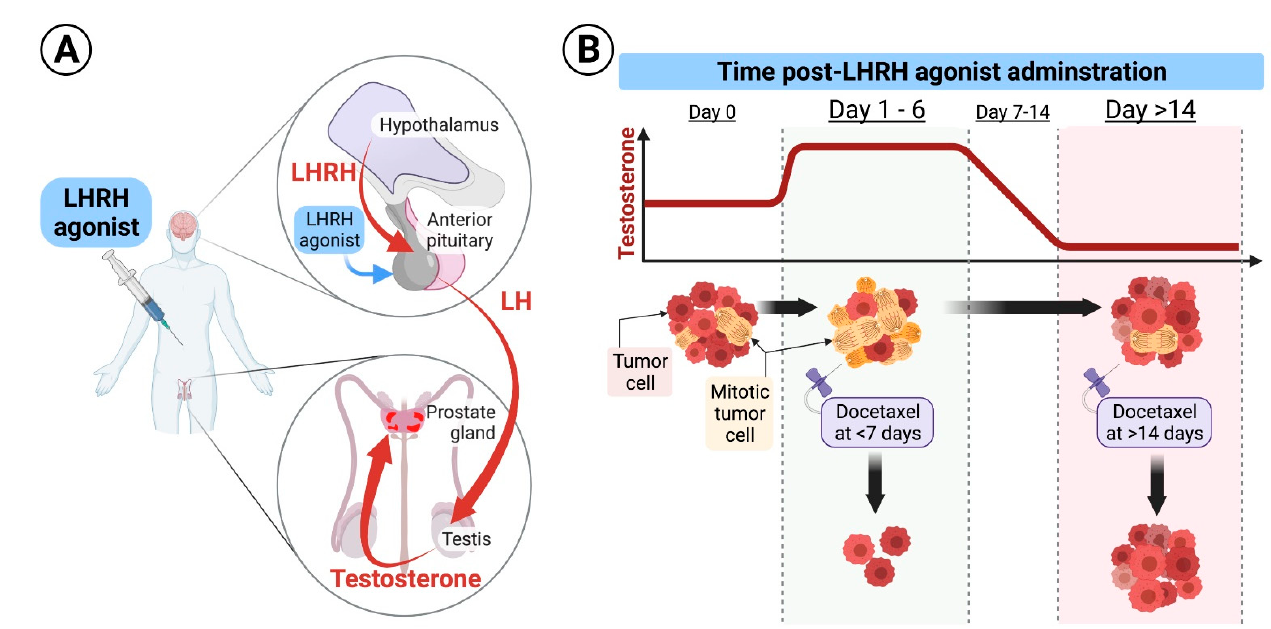
Figure 1. ( A ). Schematic diagram of the LHRH mode of action: Under physiologic conditions, the hypothalamus secretes luteinizing hormone ‐ releasing hormone (LHRH) in a cyclic manner to induce secretion of luteinizing hormone (LH) from the pituitary which results in secretion of testosterone from the testicles. LHRH agonists used for treatment of prostate cancer are formulated in long ‐ acting and continuously released forms that are injected subcutaneously and released to the systemic circulation at high levels for a protracted period of time, ranging from 1–6 months. Continuously released LHRH agonists mask the cyclic secretion of LHRH from the hypothalamus leading to drop in LH secretion from the pituitary and suppression of androgens secretion from the testicles. ( B ). Hypothetical effect of docetaxel at different times of application: Upon initiation of long ‐ acting formulations of LHRH agonists, testosterone levels surges for few days, and then start declining to castrate levels. Testosterone flare results in an increased mitosis of hormone ‐ sensitive prostate cancer cells. We hypothesize that delivery of the first dose of docetaxel during testosterone flare, at days 1–6 after LHRH initiation, results in higher cancer cell kill compared to its delivery when testosterone is at castrate levels, as docetaxel specifically inhibits microtubular depolymerization of the mitotic spindle, which results in cell kill.